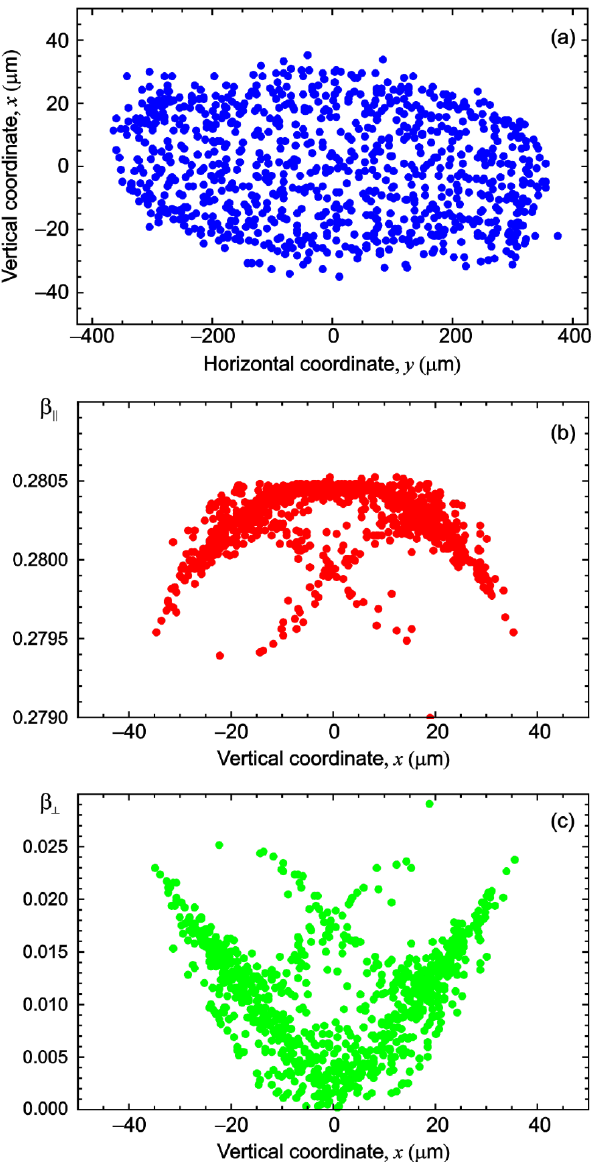
Figure 2. ( a ) Electron beam cross-section at 10 mm distance from the cathode, with corresponding distributions of ( b ) axial and ( c ) transversal velocities over the beam thickness.